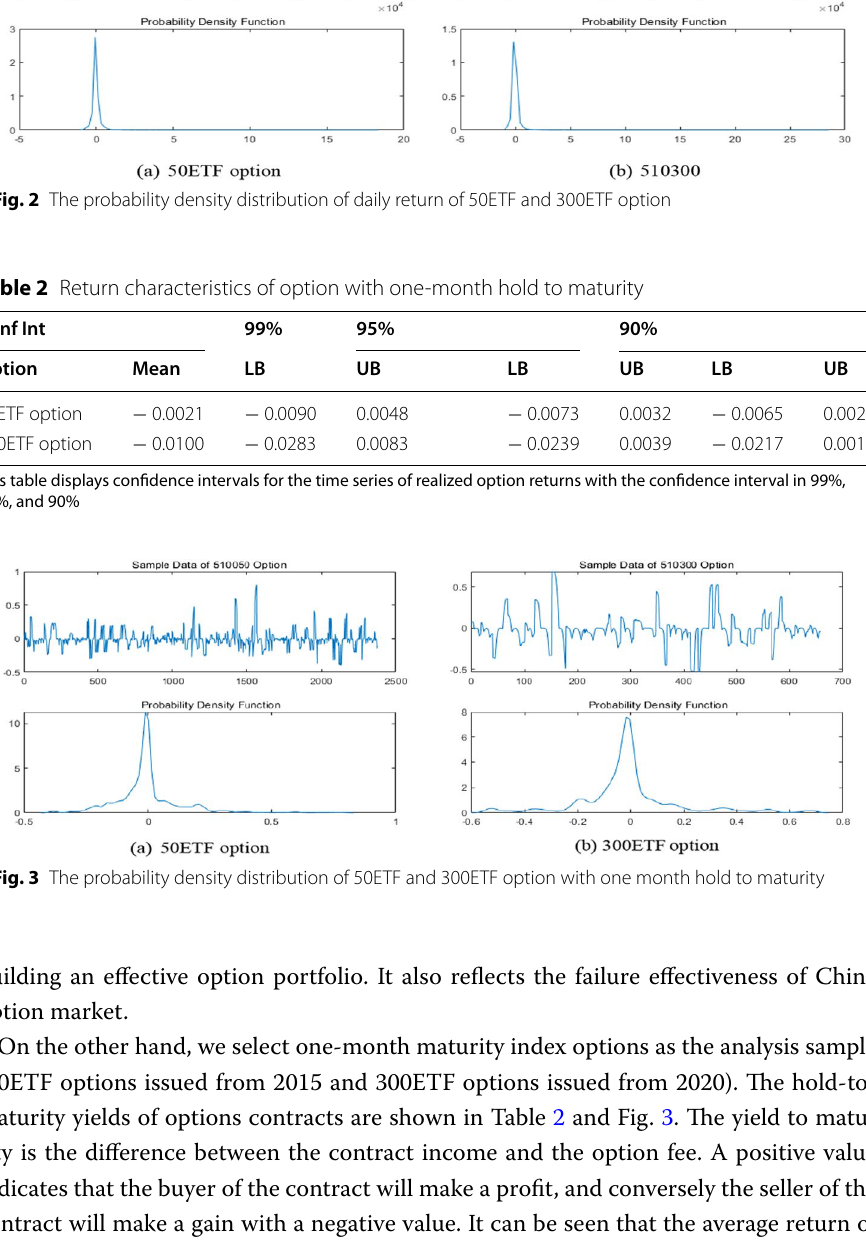
Fig. 2 The probability density distribution of daily return of 50ETF and 300ETF option